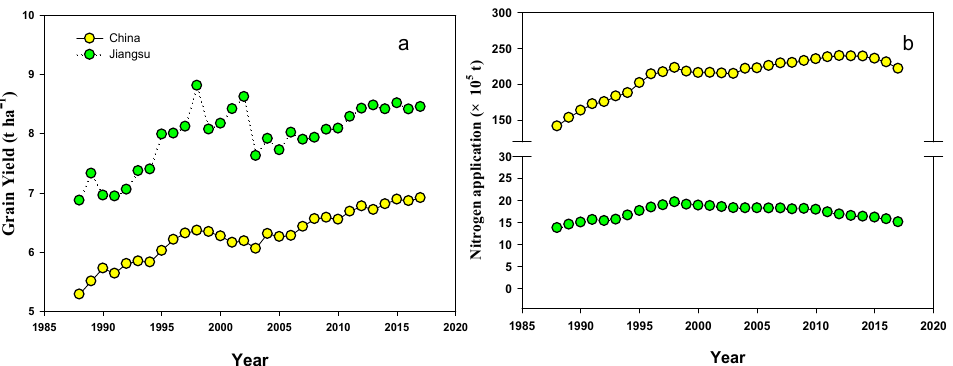
Figure 1. The average grain yield of rice ( a ) and total agricultural N application ( b ) of China and Jiangsu province in the past 30 years (data from the National Bureau of Statistics of China).